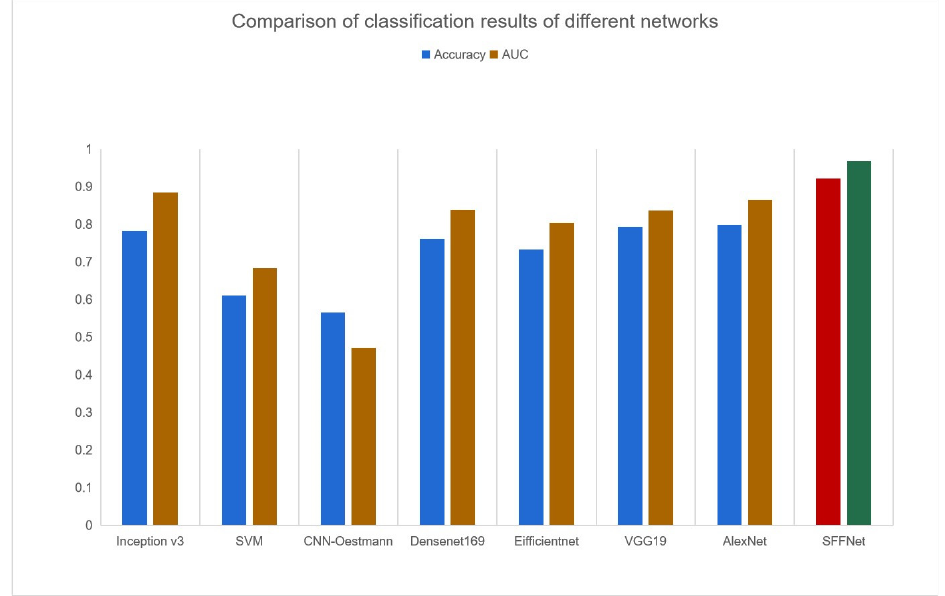
Figure 10. The experimental results of different networks (yellow and blue represent the classification accuracy and AUC value of each model, while red and green highlight the accuracy and AUC value of the model SFFNet).